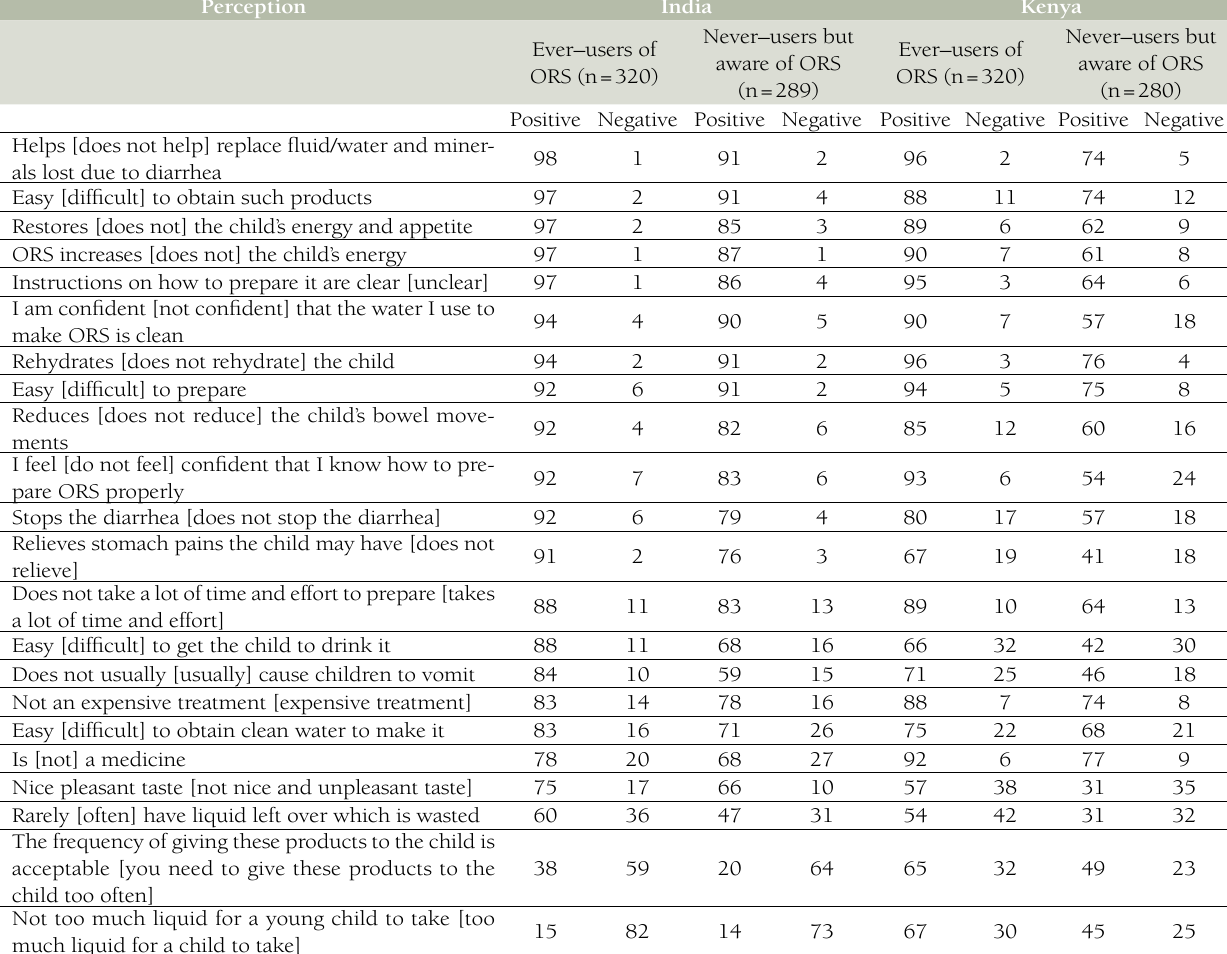
Table 4. Caregiver perceptions (% response) of ORS, on Positive [negative] paired statements*